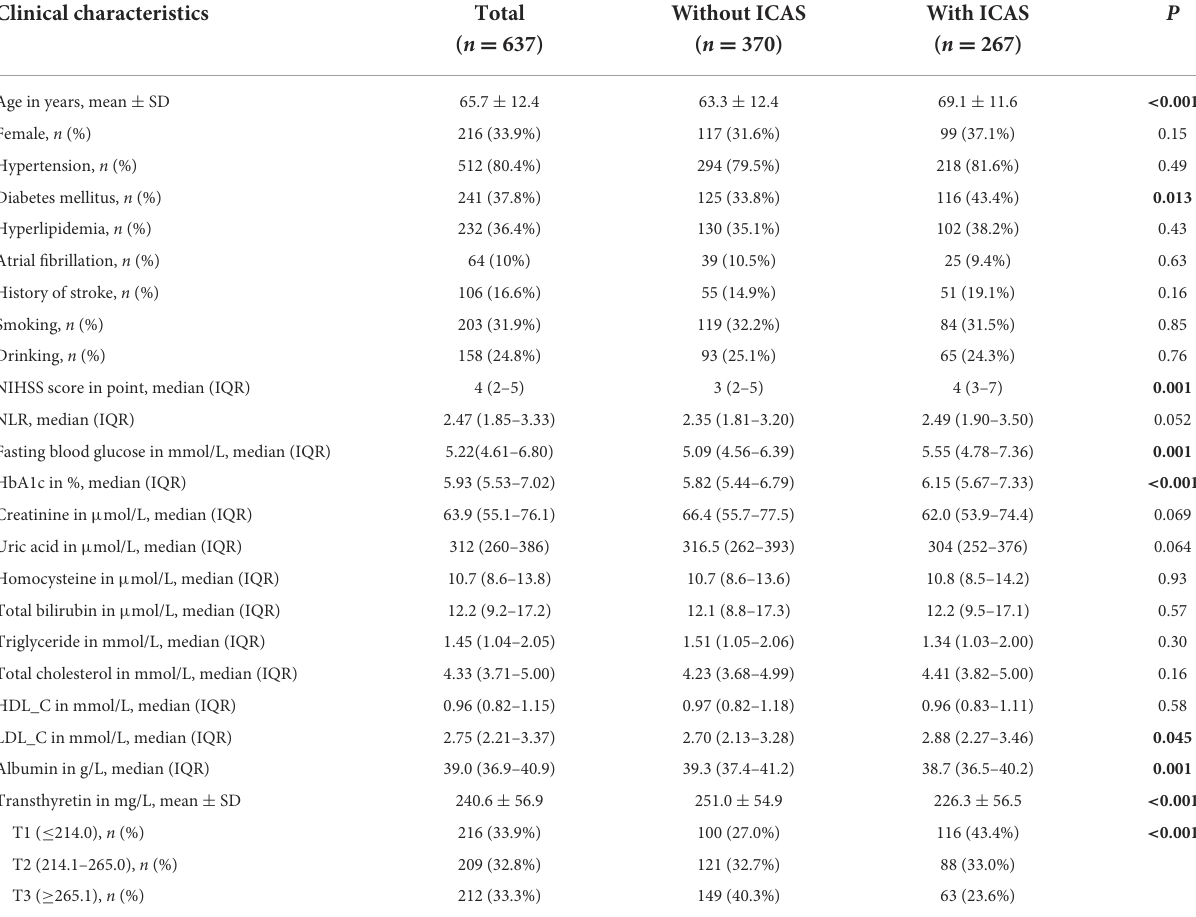
TABLE 2 Clinical characteristics of patients, stratified by the presence of